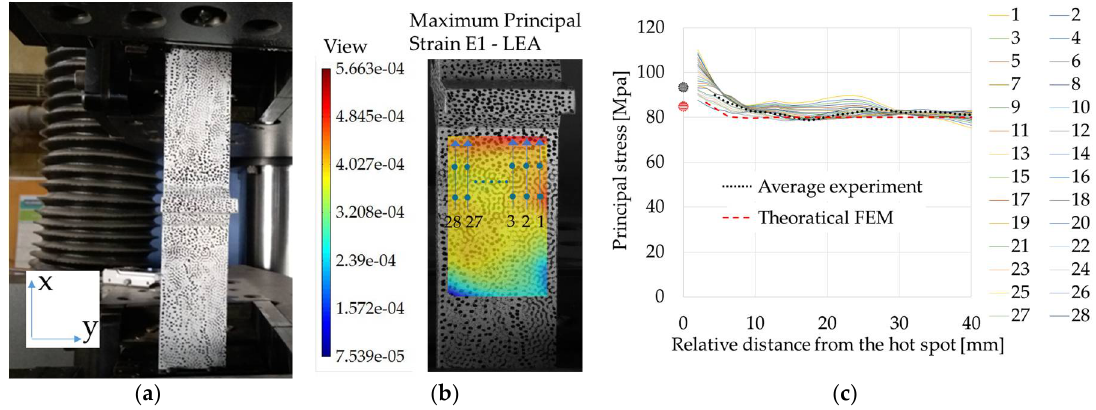
Figure 4. Experimental setup: ( a ) View of the cameras; ( b ) Extrapolation paths for the measurement of hot spot stress; ( c ) Stress extrapolation paths for the measurement of hot spot